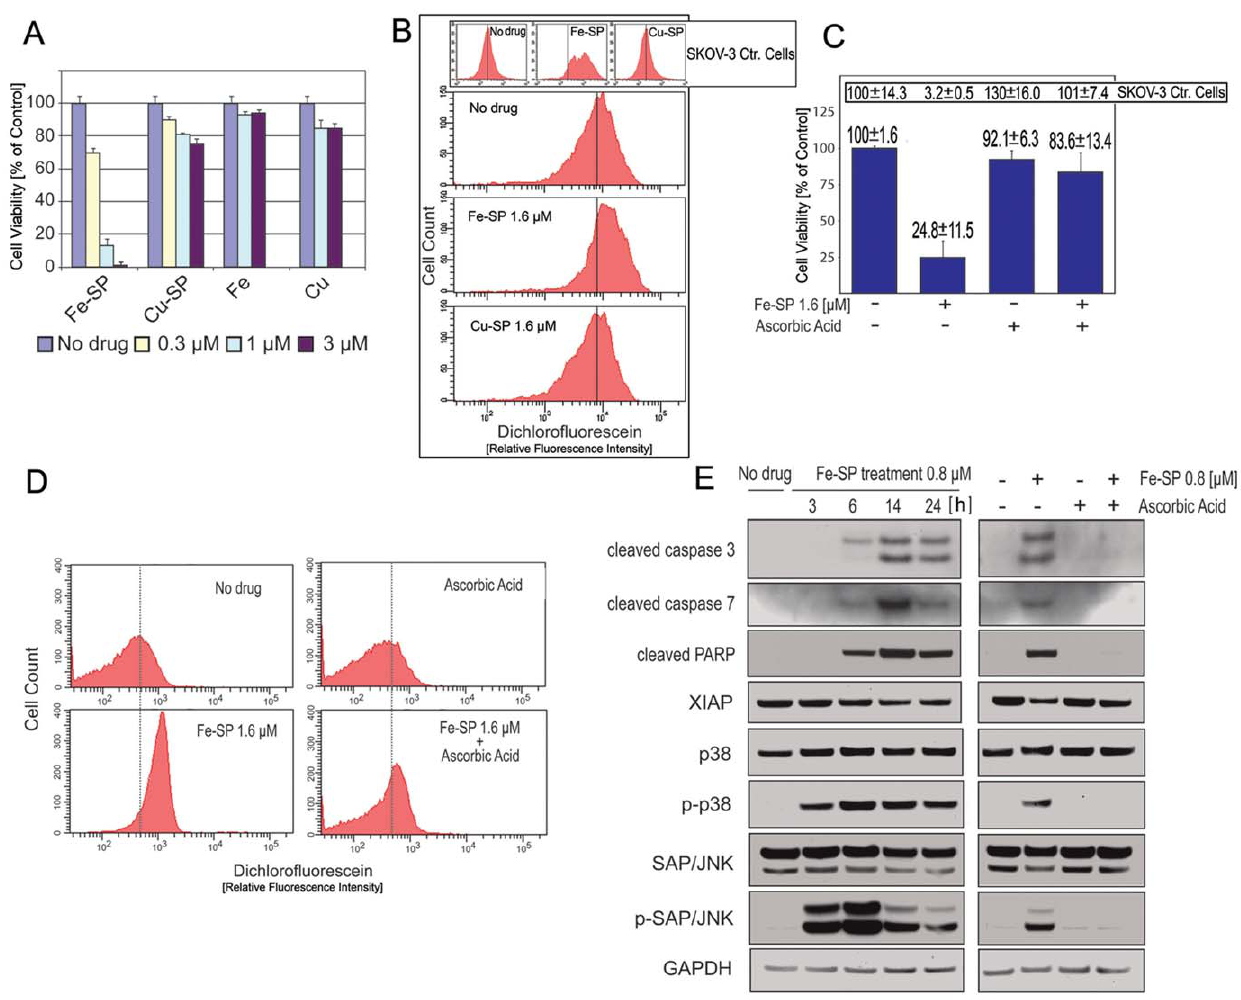
Figure 4. Effect of Fe-SP or Cu-SP on viability, ROS generation, and induction of apoptic markers and MAPK expression. ( A ) Cytotoxicity of Fe-SP or Cu-SP in NB cells. The viability assay was carried out after 24 h treatment of SMS-KCNR NB cells with 0–3 m M of Fe-SP, Cu-SP or respective metal salts. Experiments were performed in triplicates; data are expressed as the mean of the triplicate determinations (X 6 SD) of a representative experiment in % cell viability of untreated cells [=100%]. ( B ) Generation of intracellular Reactive Oxygen Species (ROS) after Fe-SP treatment. Generation of intracellular ROS following SMS-KCNR NB cells (large panels) or SKOV-3 OC control cells (small panels) after treatment for 4 h with 1.6 m M of Fe-SP or Cu-SP was measured by flow cytometry (see Materials and Methods). Data are presented as relative fluorescence intensity in a 2-dimensional FACS profile. Standardized gating was used for all samples. ( C ) Fe-SP cytotoxicity is blocked by antioxidant ascorbic acid. Cells were treated with with1.6 m M Fe-SP alone or in combination with antioxidant ascorbic acid. Viability of SMS-KCNR NB cells is presented as bar diagram and in percentages and of SKOV-3 OC control cells in percentages (insert). ( D ) Inhibiton of ROS generation in NB cells after Fe-SP treatment. Generation of intracellular ROS in SMS-KCNR NB was measured after treatment with 1.6 m M Fe-SP alone or in combination with antioxidant ascorbic acid (200 m M). ( E ) Expression of apoptotic markers and MAPK in NB cells after Fe-SP treatment with and without inhibiton of ROS generation. SMS-KCNR NB cells were treated with 0.8 m M Fe-SP in the absence (3, 6, 14, 24 h treatment, left panel) or presence of ascorbic acid (200 m M, 24 h treatment, right panel). Immunoblotting was carried out with primary antibodies against PARP-1, caspase-3, -7, pro-survival marker XIAP (inhibitor of effector caspases), and pro-apoptotic MAPK SAP/JNK or p38 in the active (phosphorylated) or inactive form. As an internal standard for equal loading blots were probed with an anti-GAPDH.